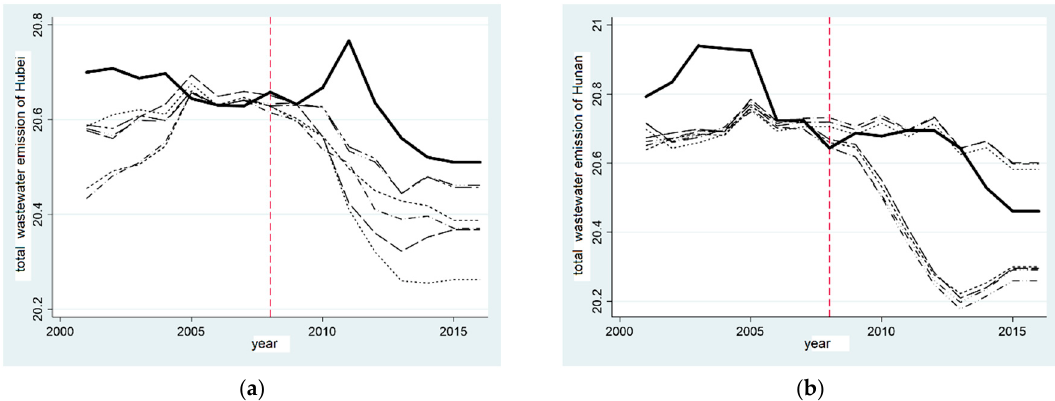
Figure 7. Sensitivity analysis of the total industrial wastewater emissions by provinces in the pilot zone of “two-oriented society”. ( a ) Hubei; ( b ) Hunan.